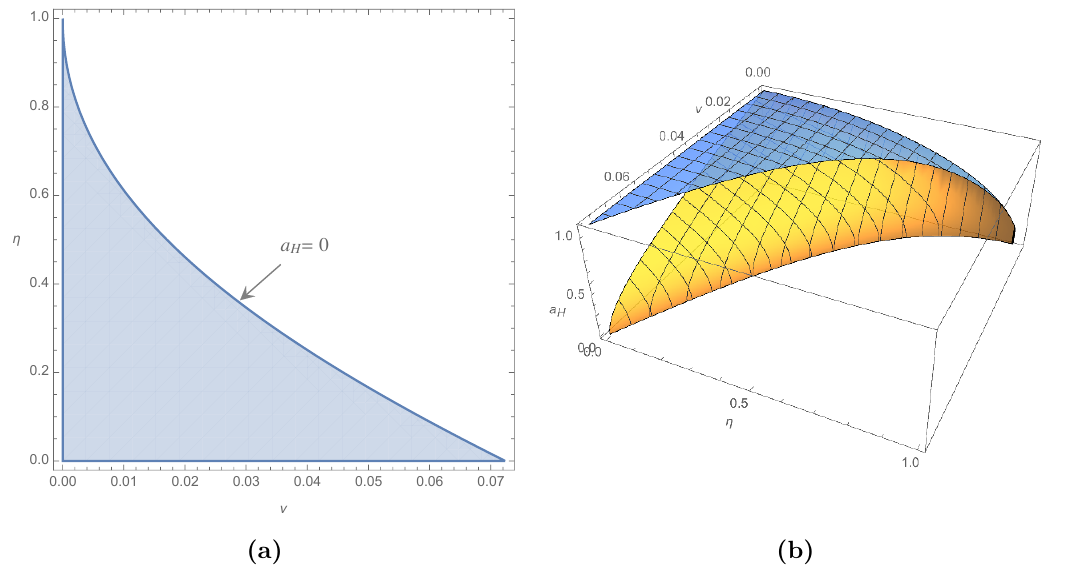
Figure 4. (a) Moduli space of the J = 0 spherical black hole I (0 < a 1 < a 2 , h 0 = 1, h 1 = (cid:0) 1, h 2 = 1). (b) Dimensionless area (orange/lighter) as compared to that of the BMPV black hole (blue/darker) in the region of overlap. In this case a H < a BMPV throughout the overlap region. leading to the